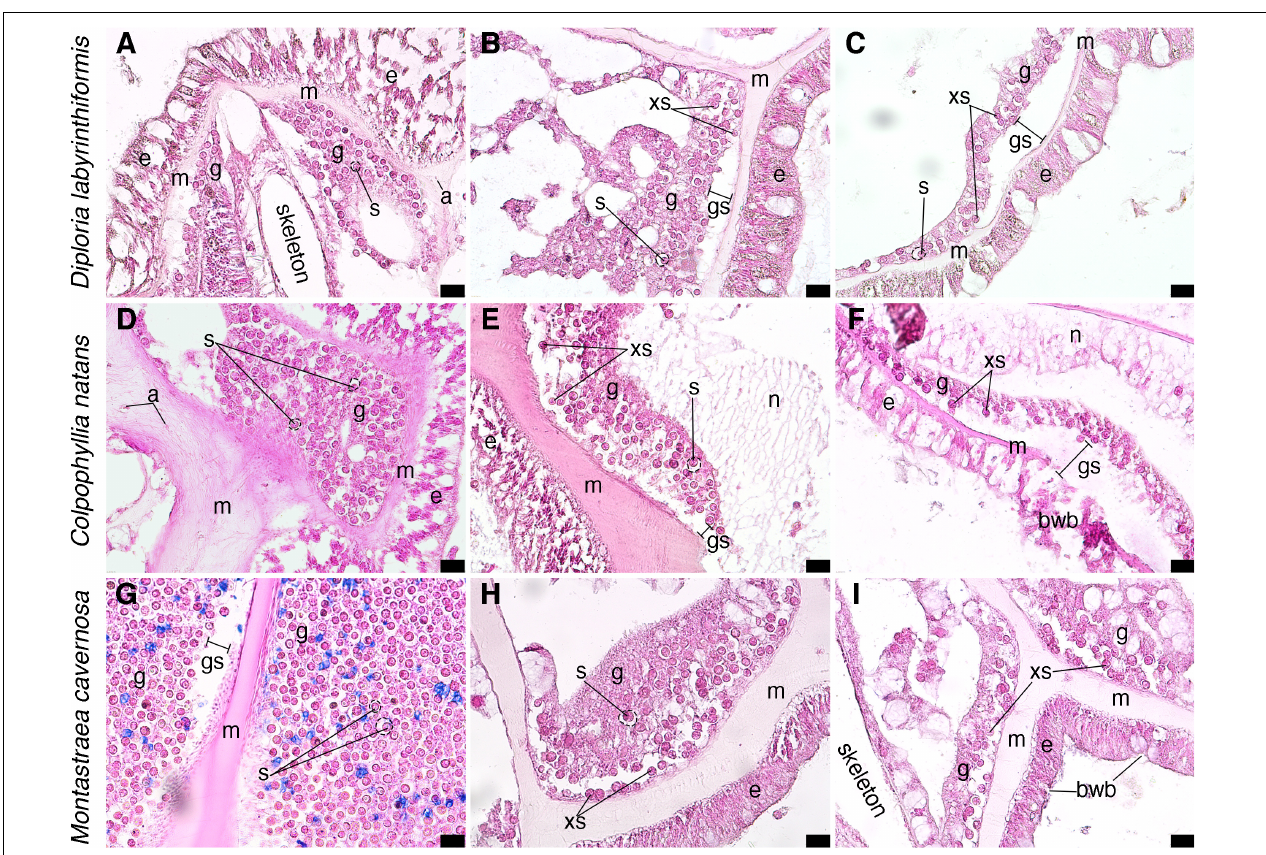
FIGURE 8 | Micrographs of coral tissue from apparently healthy and diseased colonies stained with hematoxylin and eosin. (A–C) Diploria labrynthiformis. (A) Apparently healthy tissue from a visually healthy coral, epidermis surrounds mesoglea and gastrodermis, Symbiodinaceae in gastrodermis with clearvacuoles; location of skeleton of septa prior to decalcification indicated. (B) Diseased portion of a diseased coral, epidermis bounds mesoglea which has some separation from gastrodermis with some exocytosis of Symbiodinaceae . (C) Diseased portion of a diseased coral, mesoglea separated from gastrodermis leading to exocytosis of Symbiodinaceae . (D–F) Colpophyllia natans . (D) Apparently healthy tissue from a visually healthy coral, Symbiodinaceae in gastrodermis with clear vacuoles surrounded by mesoglea containing a few presumed amoebocytes. Epidermis visible on right-hand side. (E) Apparently healthy tissue from a diseased colony, mesoglea has separated from gastrodermis, leading to exocytosis of Symbiodinaceae; webbed tissue is likely necrotic. (F) Diseased portion of a diseased coral, epidermis displays breakage and mesoglea has separated from gastrodermis leading to exocytosis of Symbiodinaceae; necrotic tissue in gastrodermis shown as fibrous tissue. (G–I) Montastraea cavernosa . (G) Apparently healthy portion of a visually healthy coral, gastrodermis on both sides of mesoglea (epidermis not visible); there may be slight gastrodermal separation from mesoglea, potentially an artifact of histological processing; Symbiodinaceae are in clear vacuoles. (H) Diseased portion of a diseased coral, mesoglea has begun to separate from gastrodermis and exocytosis of Symbiodinaceae . (I) Diseased portion of a diseased coral, epidermis is broken, mesoglea has separated from gastrodermis, and subsequent exocytosis of Symbiodinaceae; no clearly defined vacuoles around Symbiodinaceae . S, Symbiodinaceae cell with vacuoles outlined in dashed lines; g, gastrodermis; m, mesoglea; a, potential amoebocyte; e, epidermis; xs, exocytosis of Symbiodinaceae cell; gs, gastrodermal separation; bwb, body wall breakage. Scale bars indicate 20 µ m, all micrographs taken at